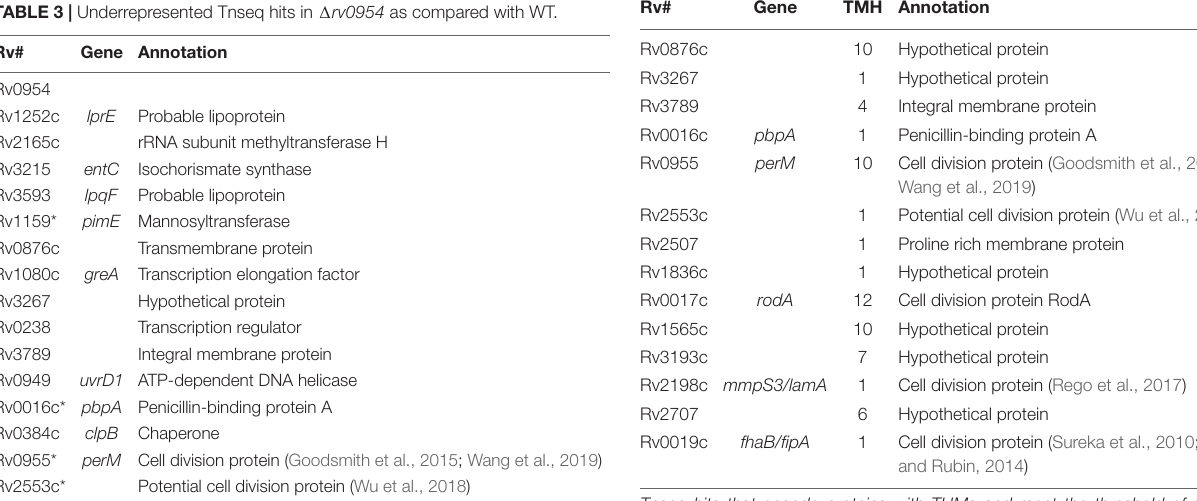
TABLE 3 | Underrepresented Tnseq hits in (cid:49) rv0954 as compared with WT.